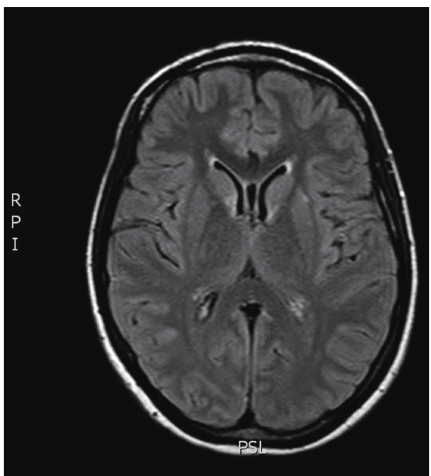
Figure1:BrainMRI(T1-weightedimage)showeddiffuseswellingof the brain due to extensive edema of the white matter characterized loss of gray-white junction and collapse of the ventricles (arrows).